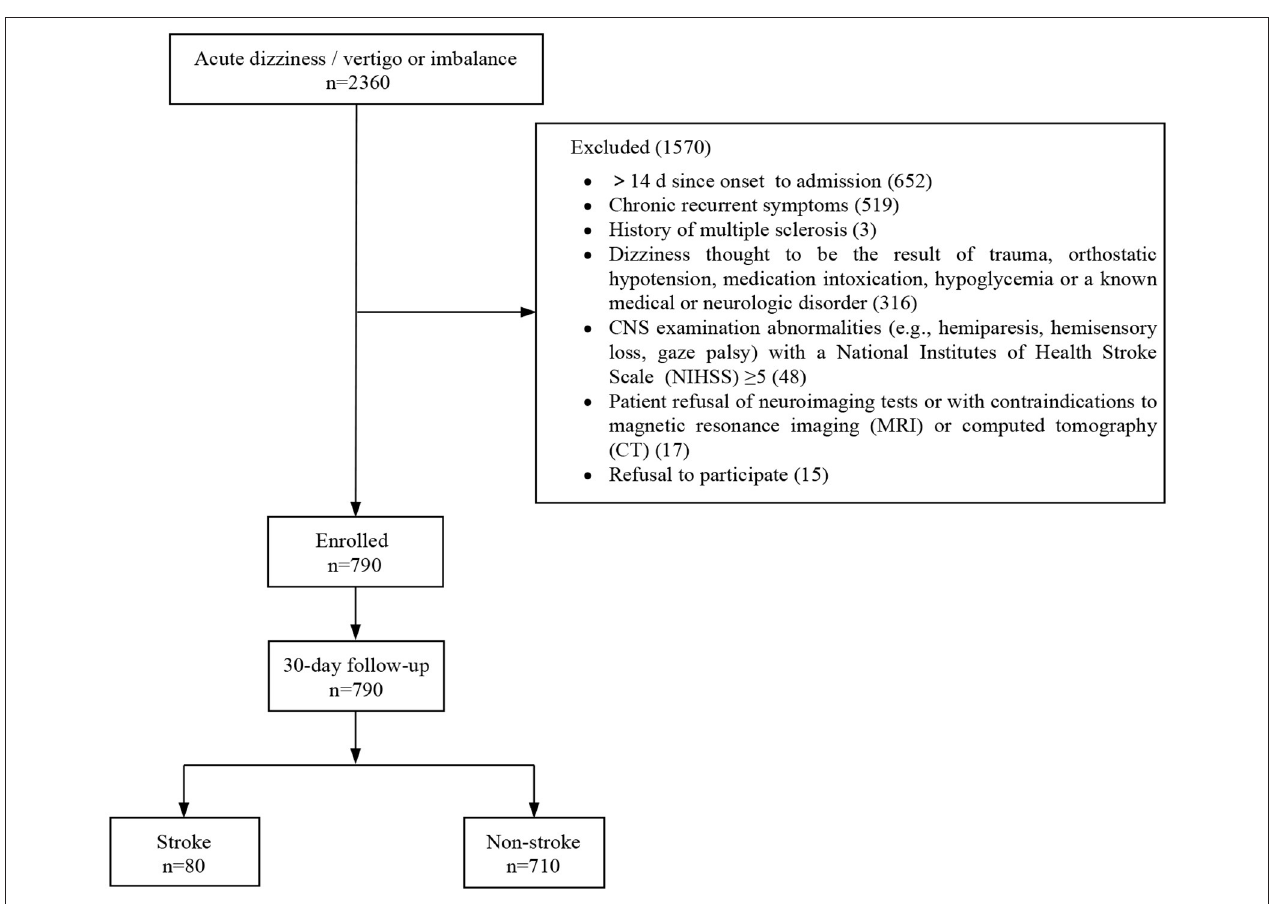
FIGURE 1 | Flowchart of patient